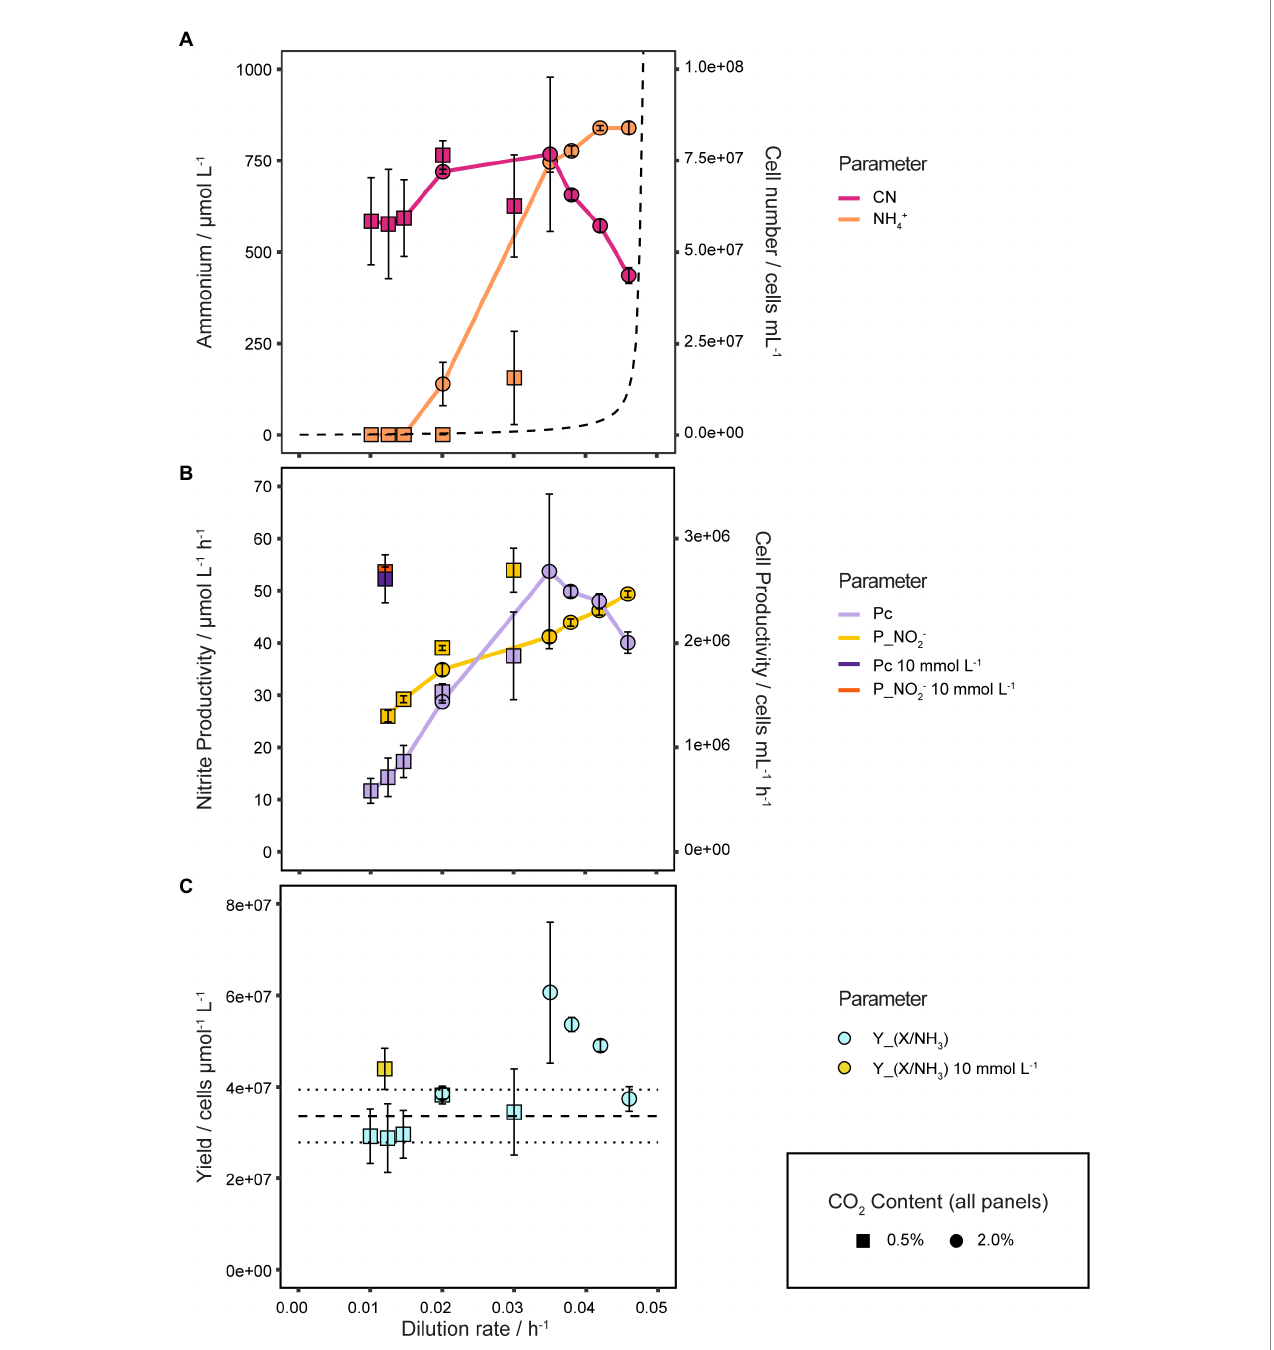
FIGURE 6 Quantitative analysis of physiological growth parameters. (A) Cell number and S in response to different D and CO 2 concentrations. The dashed line shows the theoretical development of S with increasing D assuming Monod kinetics, K s equal to K m(app) of 5.4 μ mol L − 1 and μ max of 0.048 h − 1 , illustrating the difference to the observed growth behavior of N. viennensis . NH 4+ and cell number curves show the mean values of biological duplicates, of which each NH 4+ value consists of technical triplicates (samples taken at different time points), and error bars represent the standard deviation of the mean. (B) Nitrite (P NO2 ) and cell productivity (P C ) of 2 and 10 mmol L − 1 NH 4 Cl continuous cultures at different D and CO 2 concentrations. P NO2 and P C neither correlate in a fixed 1:1 ratio as would be expected for 0.5% nor 2% CO 2 gassed cultures, indicating a variable Y (X/NH3) . P NO2 and P C points show mean values of biological duplicates, triplicates for D of 0.0124 h − 1 and 0.0146 h − 1 , and error bars represent the standard deviation of the mean. (C) Y (X/NH3) in response to different D and CO 2 concentrations. Y (X/NH3) points show mean values of biological duplicates, triplicates for D = 0.0124 h − 1 and 0.0146 h − 1 , and error bars represent the standard deviation of the mean. Points with small standard deviation may not have visible error